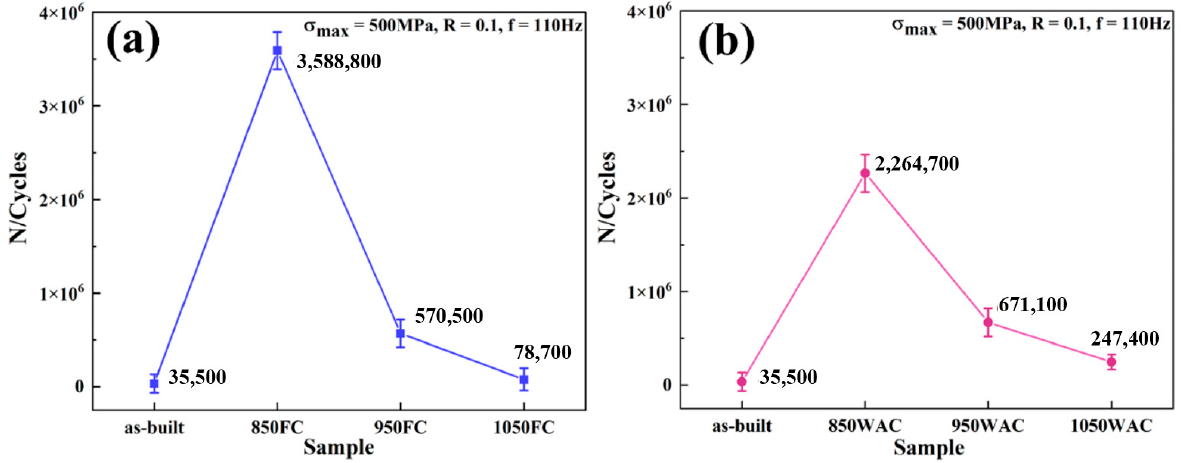
Figure 6. Average fatigue life(N) change curve of different heat-treated specimens: ( a ) AT, ( b ) SAT.